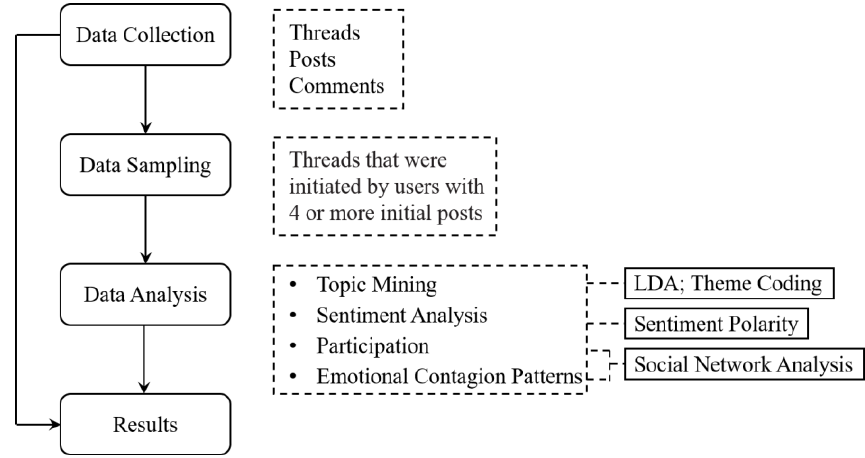
Figure 1. Research process to evaluate RQ1, RQ2, and RQ3.